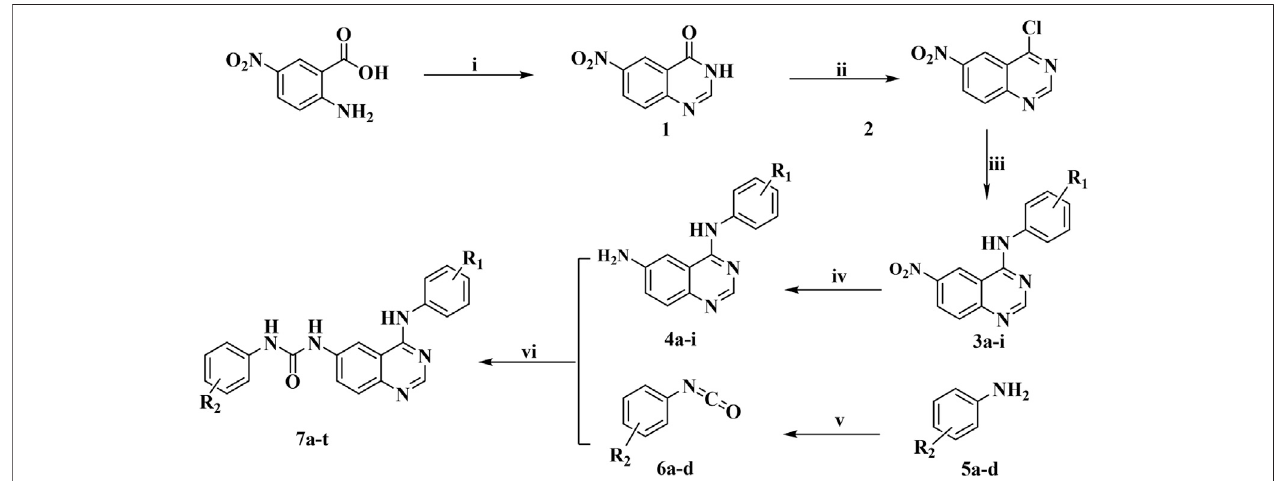
FIGURE 2 | Synthetic route of the target Compounds 7a – t